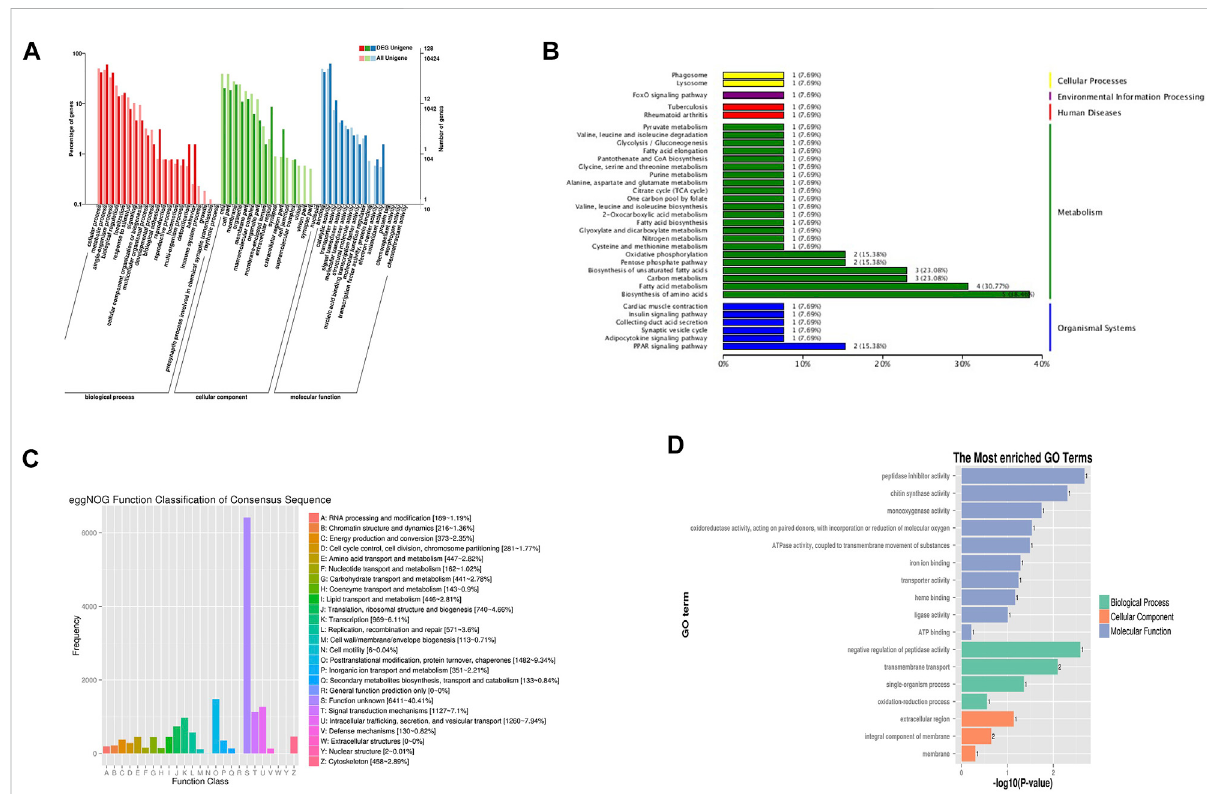
FIGURE 4 RNA-seq transcriptomic assay results. (A) The GO annotation of differentially expressed genes. (B) The KEGG pathway annotation of differentially expressed genes. (C) The eggNOG function classi fi cation of consensus sequence. (D) The GO annotation of the most enriched expressed